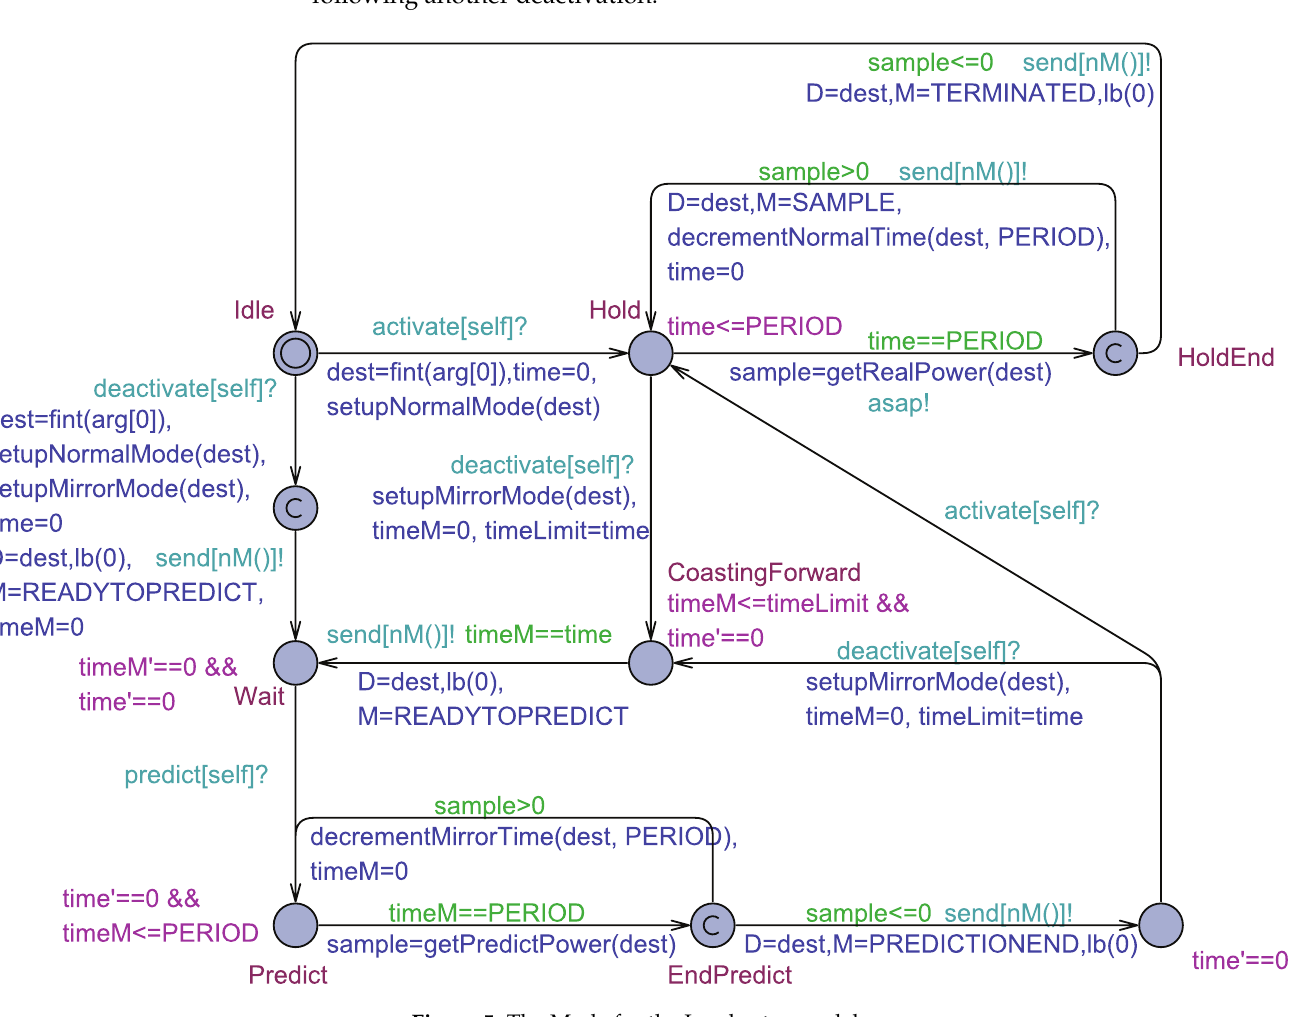
Figure 5. The Mode for the Load actor